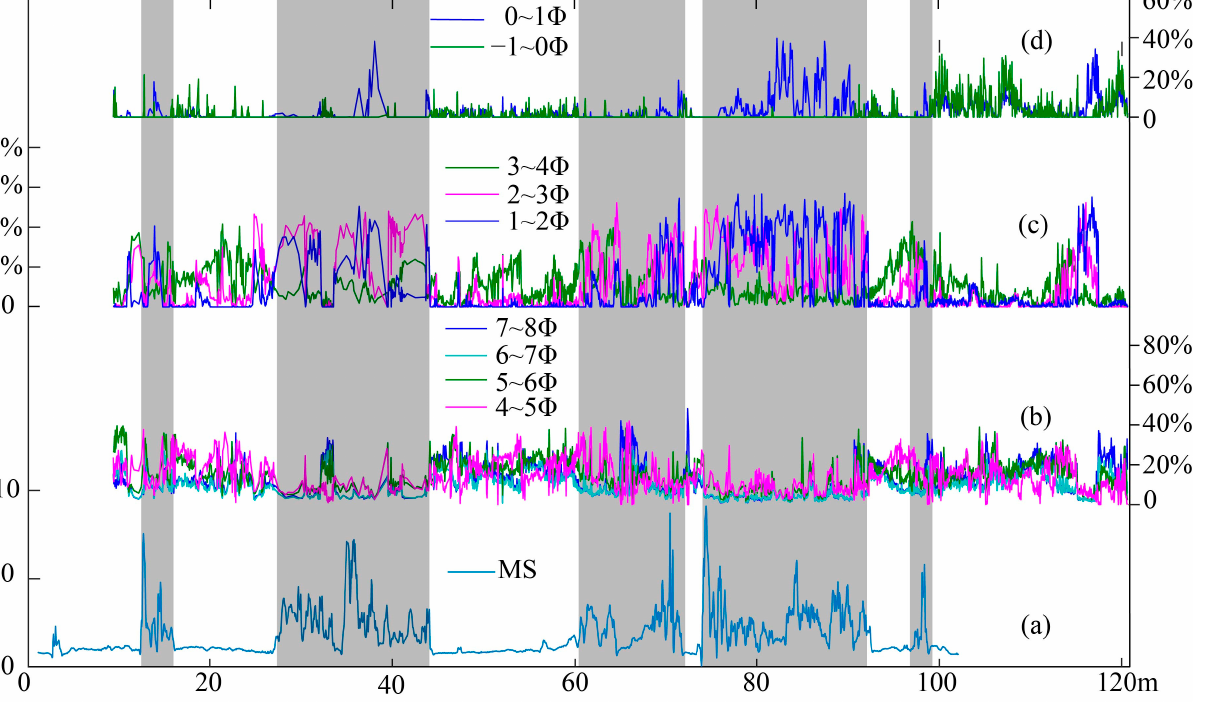
Figure 4. Comparison diagram between MS and grain size of the SHBZK-1 core. ( a ) MS curve; ( b ) silt (4~8 𝚽 ) curve; ( c ) sand (1~4 𝚽 ) curve; ( d ) coarse sand ( − 1~1 𝚽 ) curve. (4~8 Φ ) curve; ( c ) sand (1~4 Φ ) curve; ( d ) coarse sand ( − 1~1 Φ )